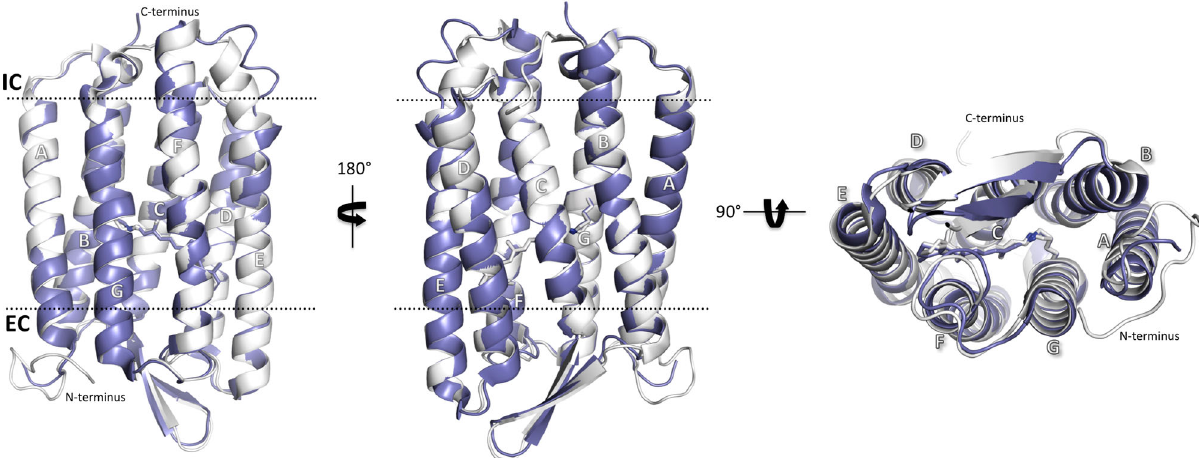
Fig. 1 Comparison of the light-adapted (LA) AR3 (6S6C [http://doi.org/10.2210/pdb6S6C/pdb], white) and bR (5ZIM [http://doi.org/10.2210/ pdb5ZIM/pdb] purple) crystal structures. The approximate positions of the extracellular (EC) and intracellular (IC) membrane interfaces are shown as black dotted lines. The retinylidene chromophore (formed by the post-translational conjugation of retinal to a lysine sidechain) is shown in stick representation. The transmembrane helices (shown in ribbon representation) are labeled from A to G. The N termini of both proteins face the extracellular (EC) side of the membrane and the C-termini face the intracellular (IC)